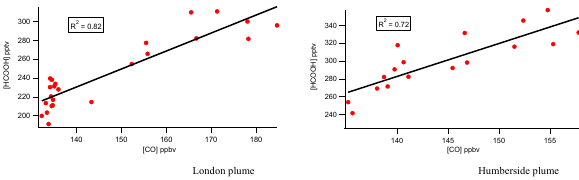
Figure 6. Correlation plots of HCOOH v CO for the London and Humberside plumes. Fig. 6. Correlation plots of HCOOH vs. CO for the London and Humberside